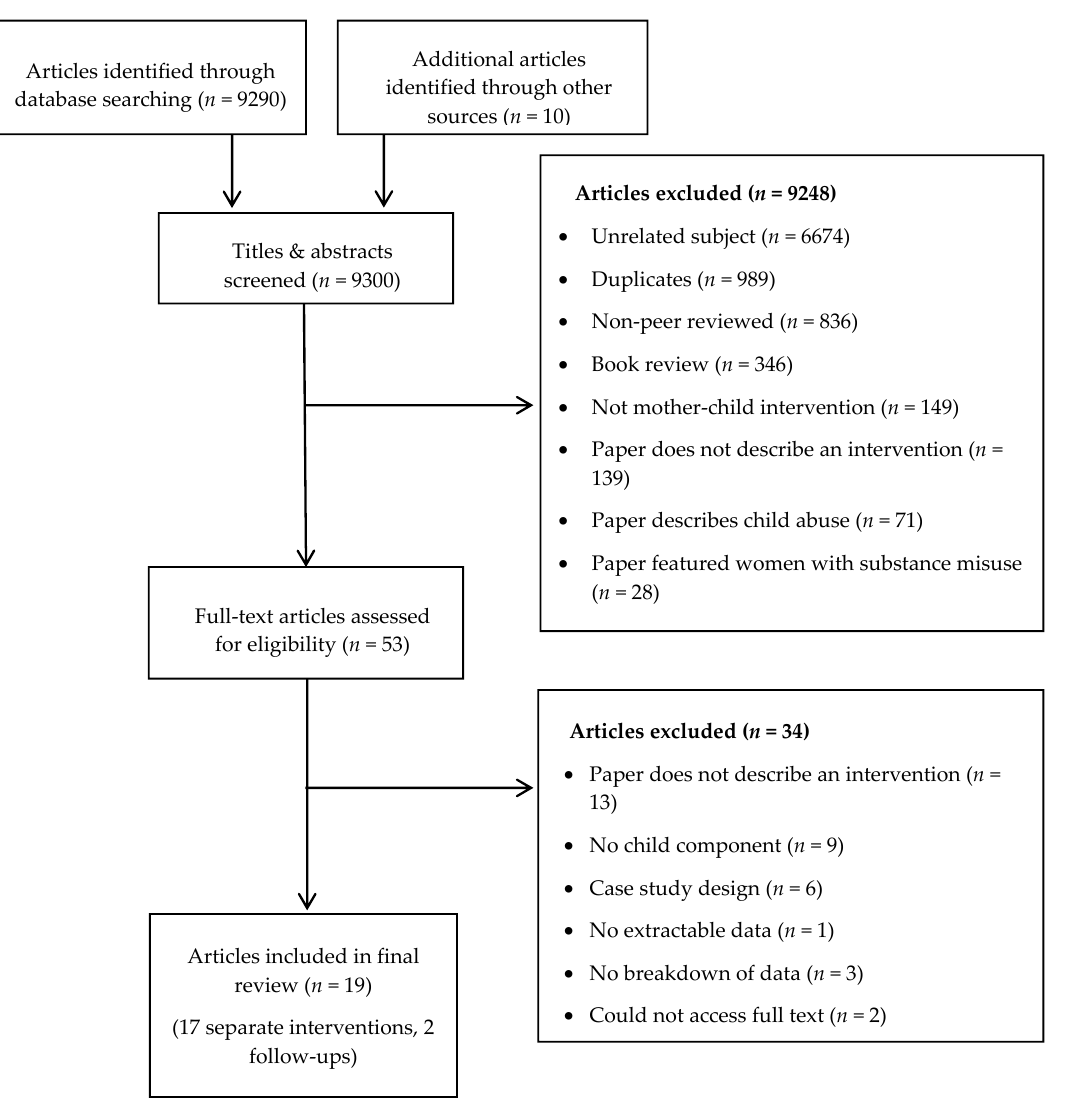
Figure 1. Flow diagram for article selection.